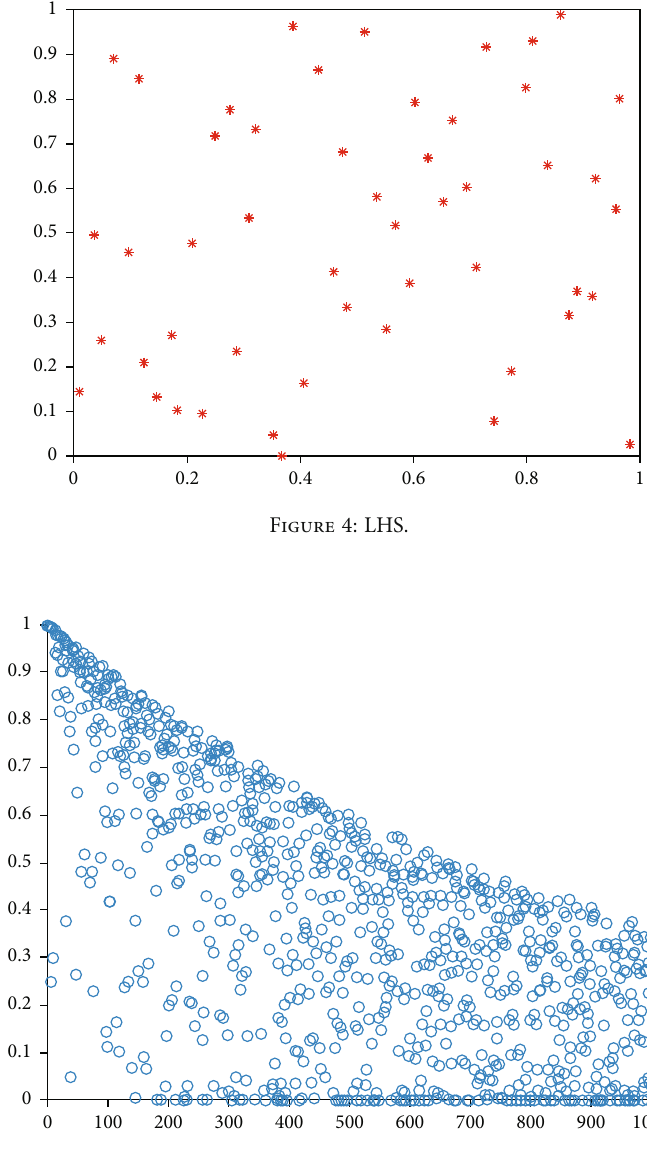
Figure 5: f ð x Þ = exp ð − x /1000 × α Þ